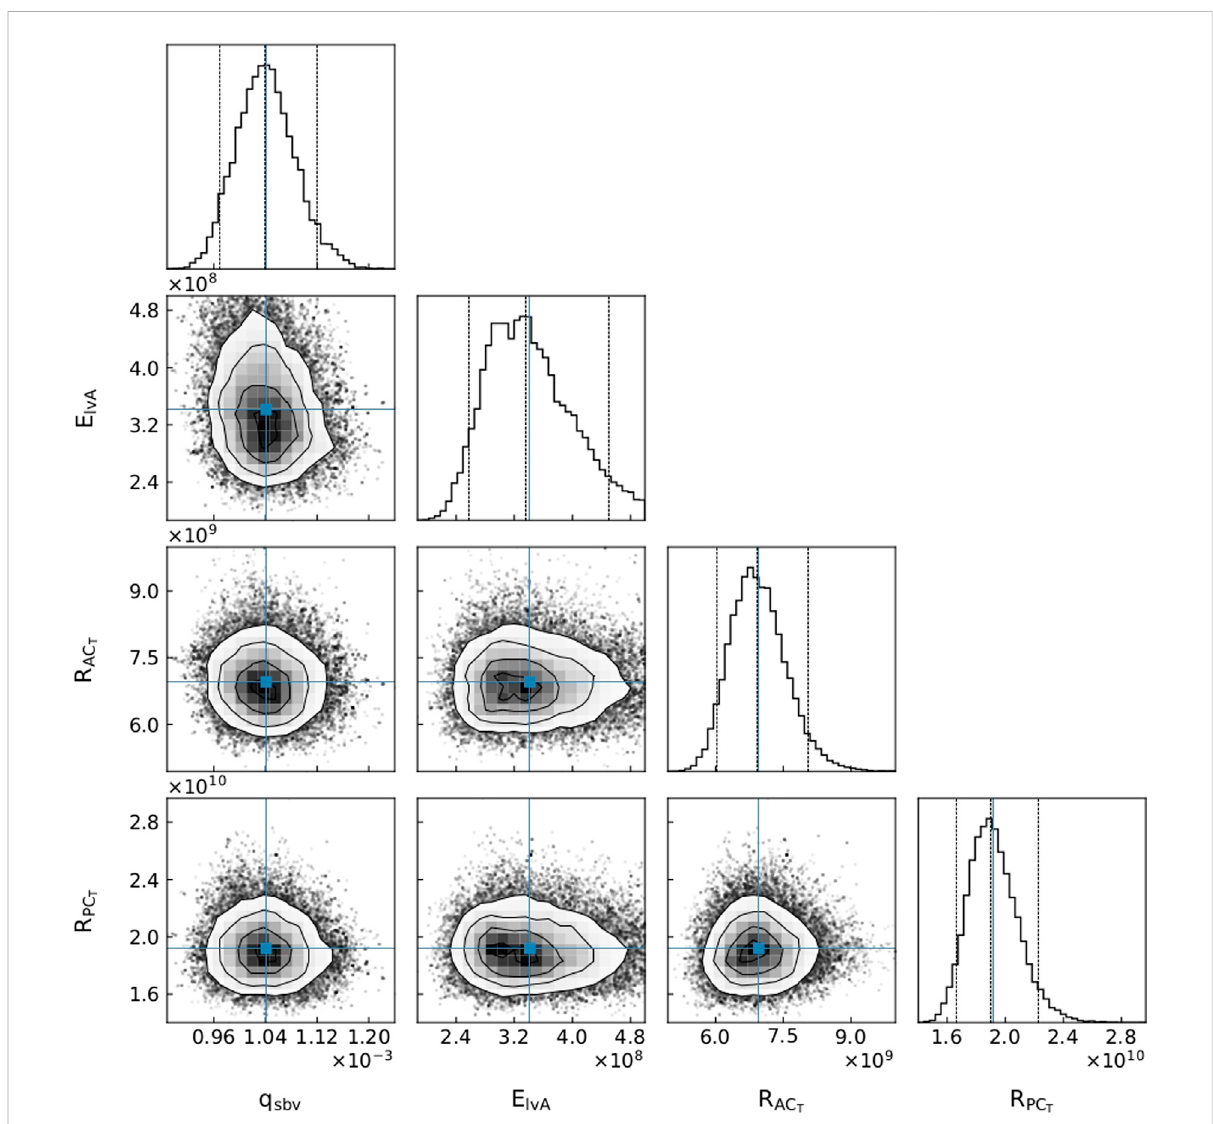
FIGURE 5 A subset of parameter distributions for Patient 1. q sbv : stressed blood volume, E lvA : left ventricle maximum elastance, R AC T : anterior cerebral terminal resistance, R PC T : posterior cerebral terminal